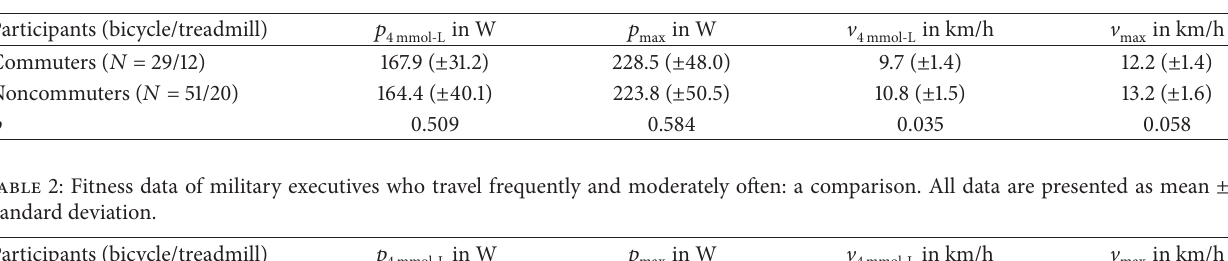
Table 1: Comparison of the fitness data of commuters and noncommuters. All data are presented as mean ± standard deviation.